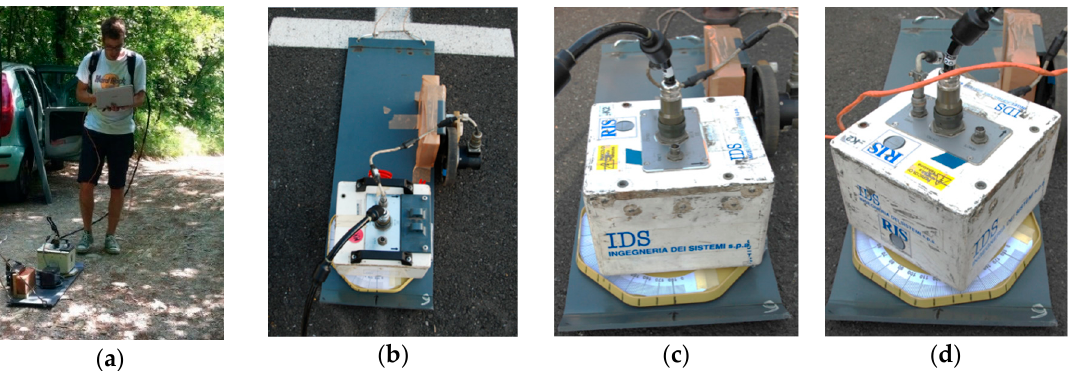
Figure 2. Acquisition campaign details: ( a ) Photograph of the survey process; ( b ) dedicated GPR platform, in which the mechanical protractor is visible below the antenna; and ( c,d ) examples of antenna rotation.